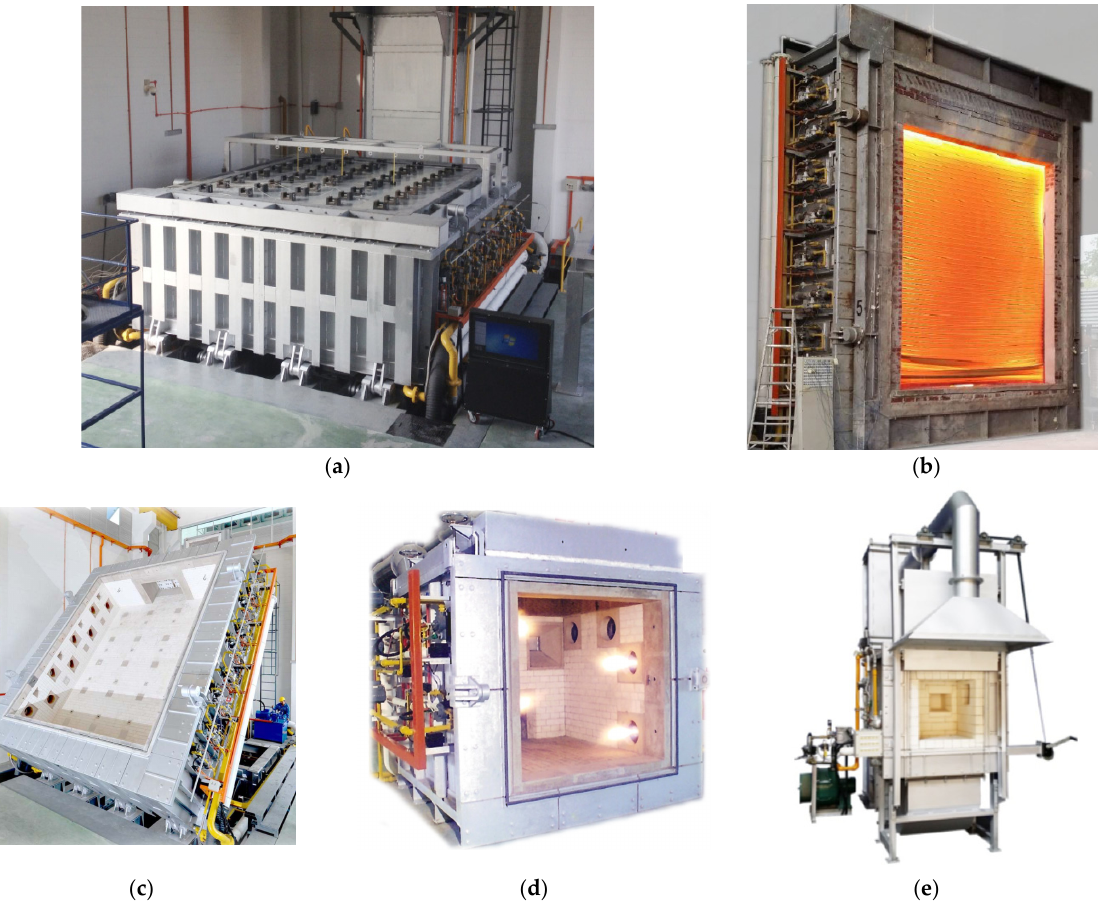
Figure 2. Test furnaces: ( a ) horizontal, ( b ) vertical, ( c ) hydraulic, ( d ) indicative, and ( e ) miniature.